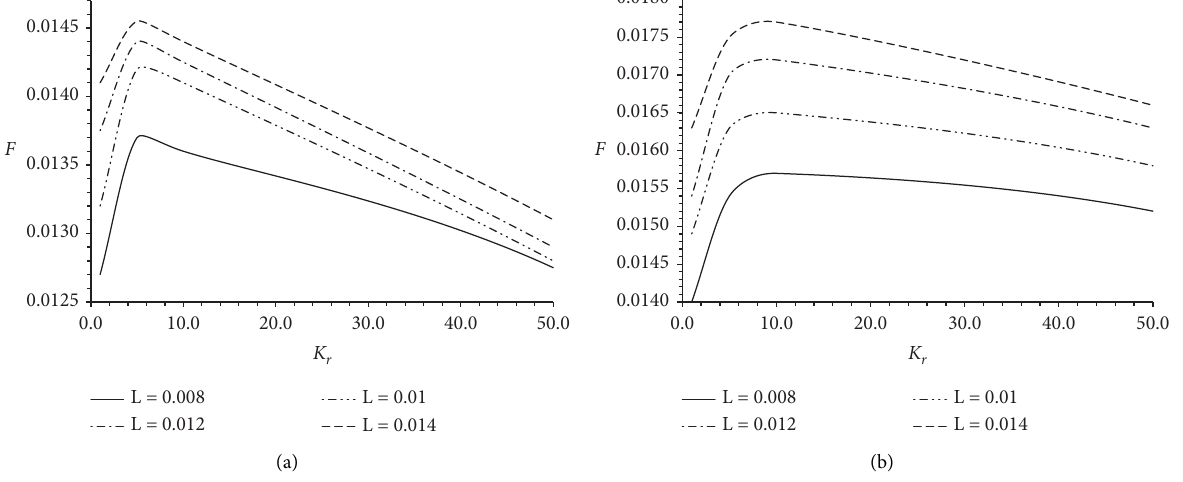
� 0.5, δ � 0.2, δ � 0.1; (a) E � 0.1, (b) E � o i